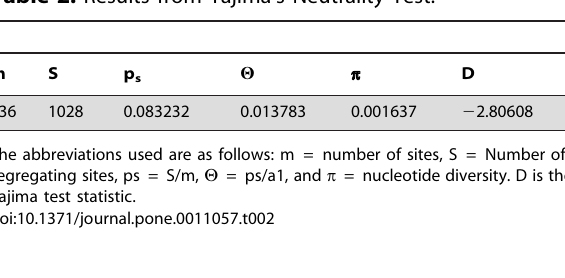
Table 1. Evolutionary parameters of A(H1N1)pdm viruses based on the full-genome sequence.